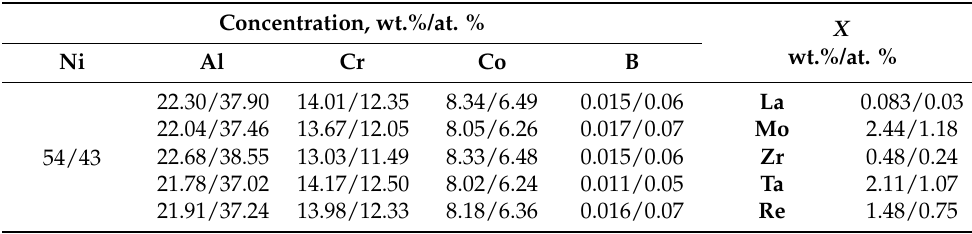
Table 3. The chemical composition of the NiAl–Cr–Co –( X ) alloys. Concentration, wt.%/at. % X